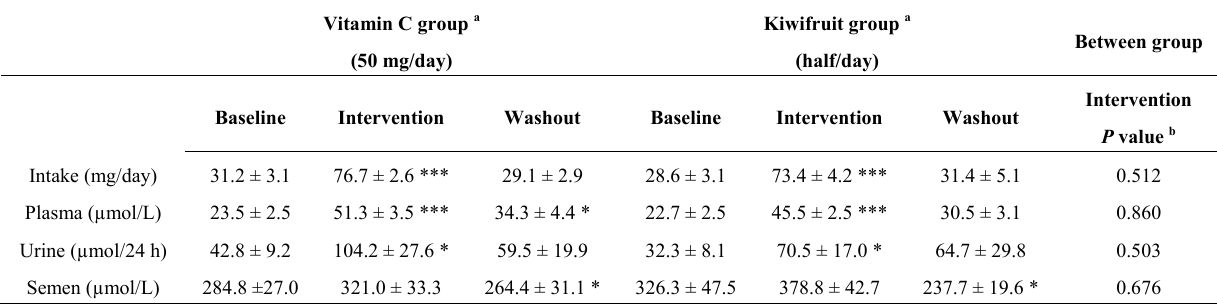
Table 2. Change in vitamin C intake and ascorbate concentration in body fluids, cells and tissue following supplementation with 50 mg vitamin C or half a kiwifruit per day for six